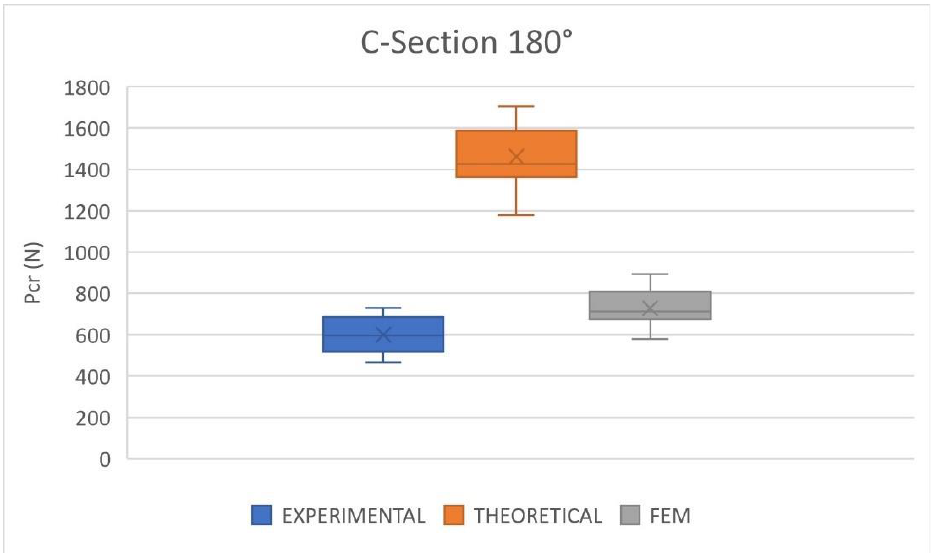
Figure 12. Critical buckling load. Comparison between experimental, theoretical and FEM results. C180 cross-section. Table 3. Comparative results of the three cross-sections. Including average, maximum, and mini-